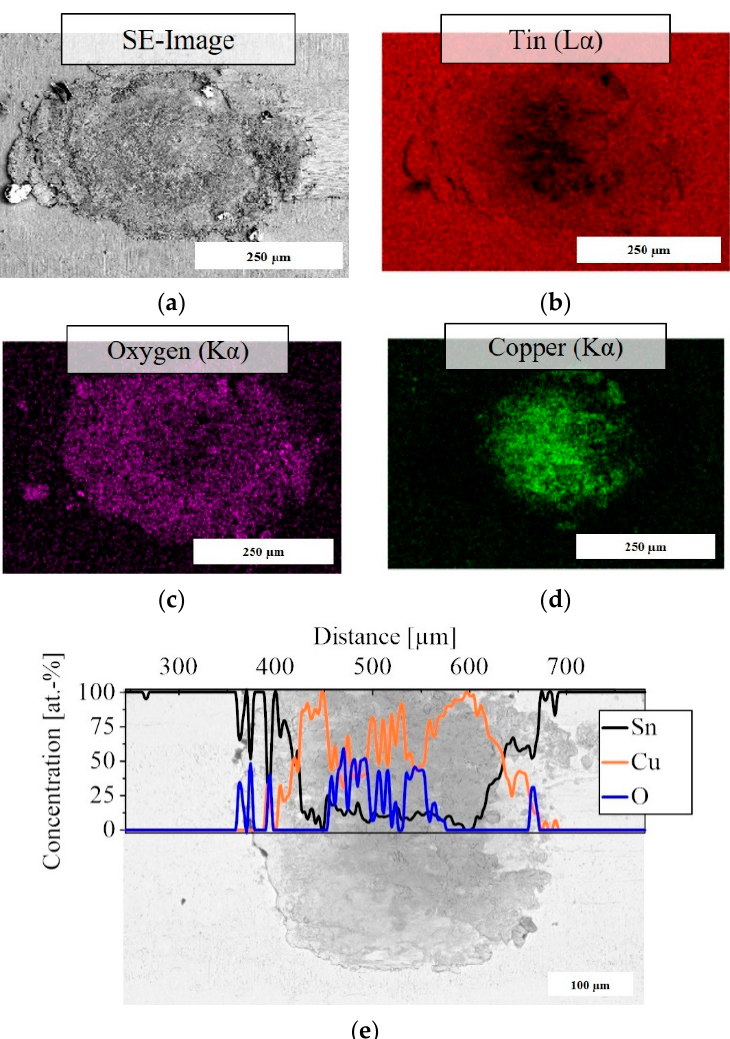
Figure 4. EDS analysis of chemical elements of electrical connectors after a fretting corrosion test (acceleration voltage 20 kV): ( a ) SE-Image of the contact area; ( b ) Element mapping of tin; ( c ) Element mapping of oxygen; ( d ) Element mapping of copper; ( e ) Line scan across the contact area.